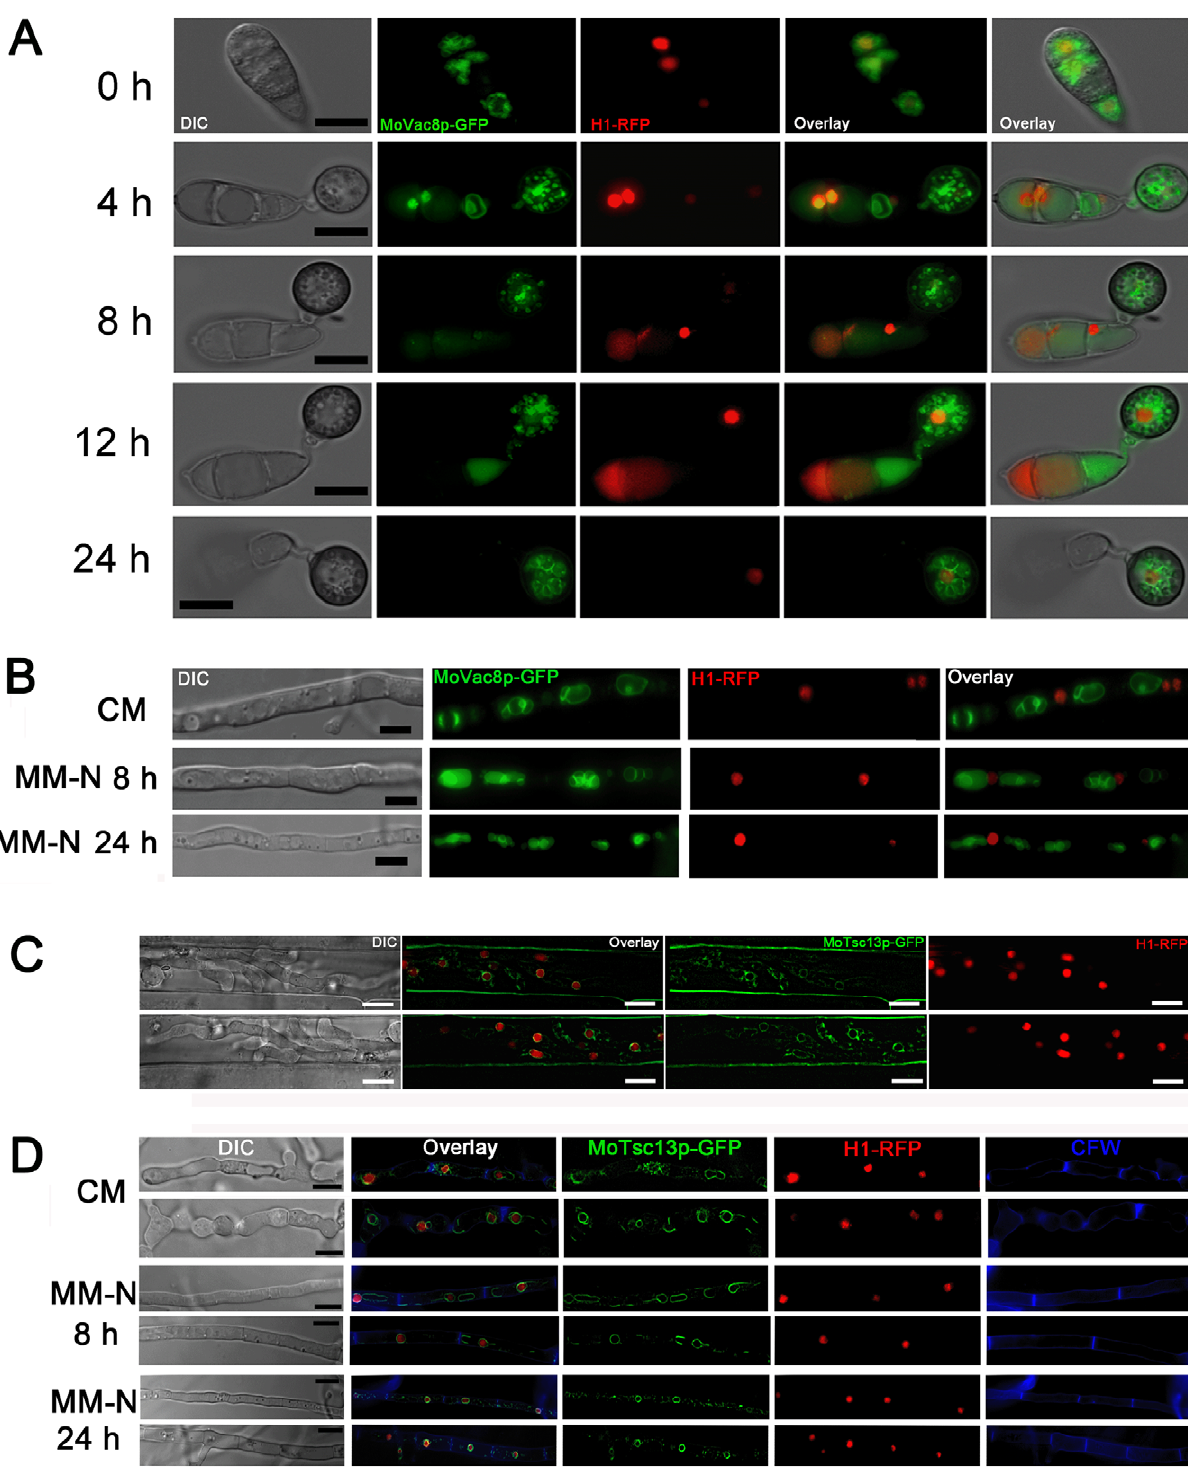
PLoS ONE | www.plosone.org